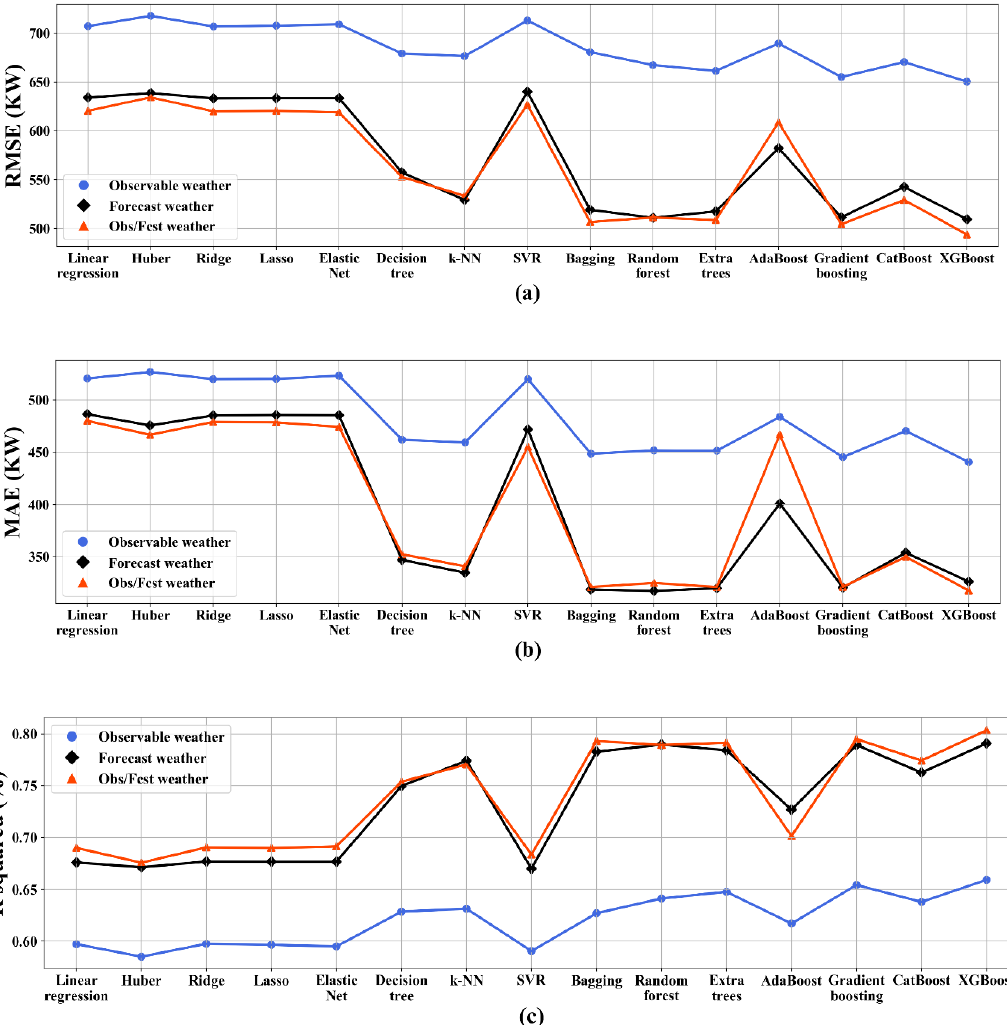
Figure 3. Comparative algorithm analysis using test set over weather data. ( a ) RMSE, ( b ) MAE, ( c ) R 2 .